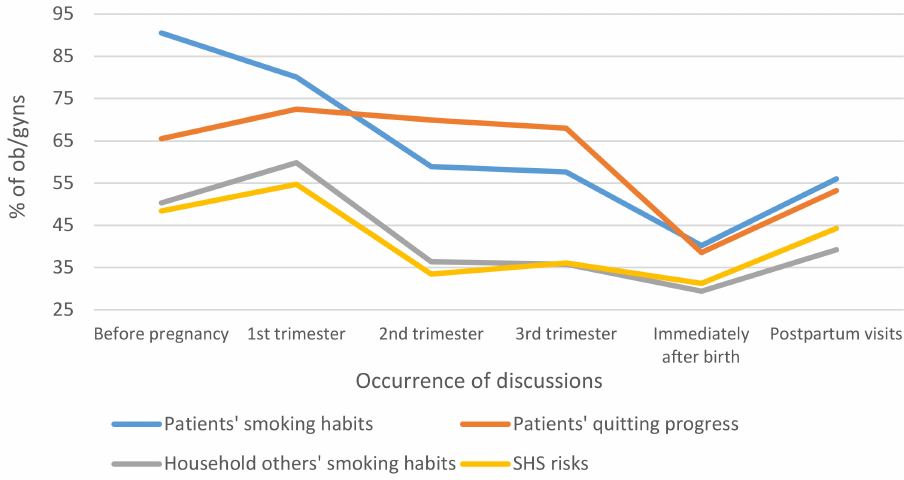
Figure 2. Occurrence of smoking-related